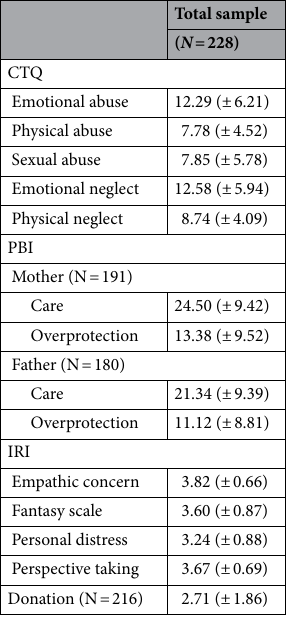
Table 1. Descriptive data for early life adversity and empathy. Descriptive data are presented as mean (± standard deviation). CTQ childhood trauma questionnaire, PBI parental bonding instrument, IRI interpersonal reactivity index.